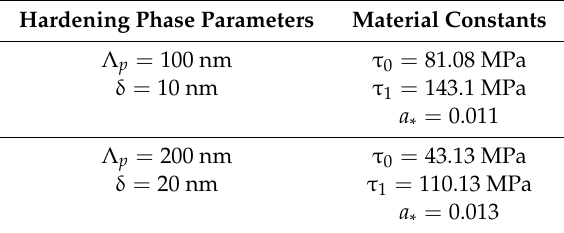
Table 1. The material constants τ 0 ∗ , τ 1 ∗ and a ∗ (1).